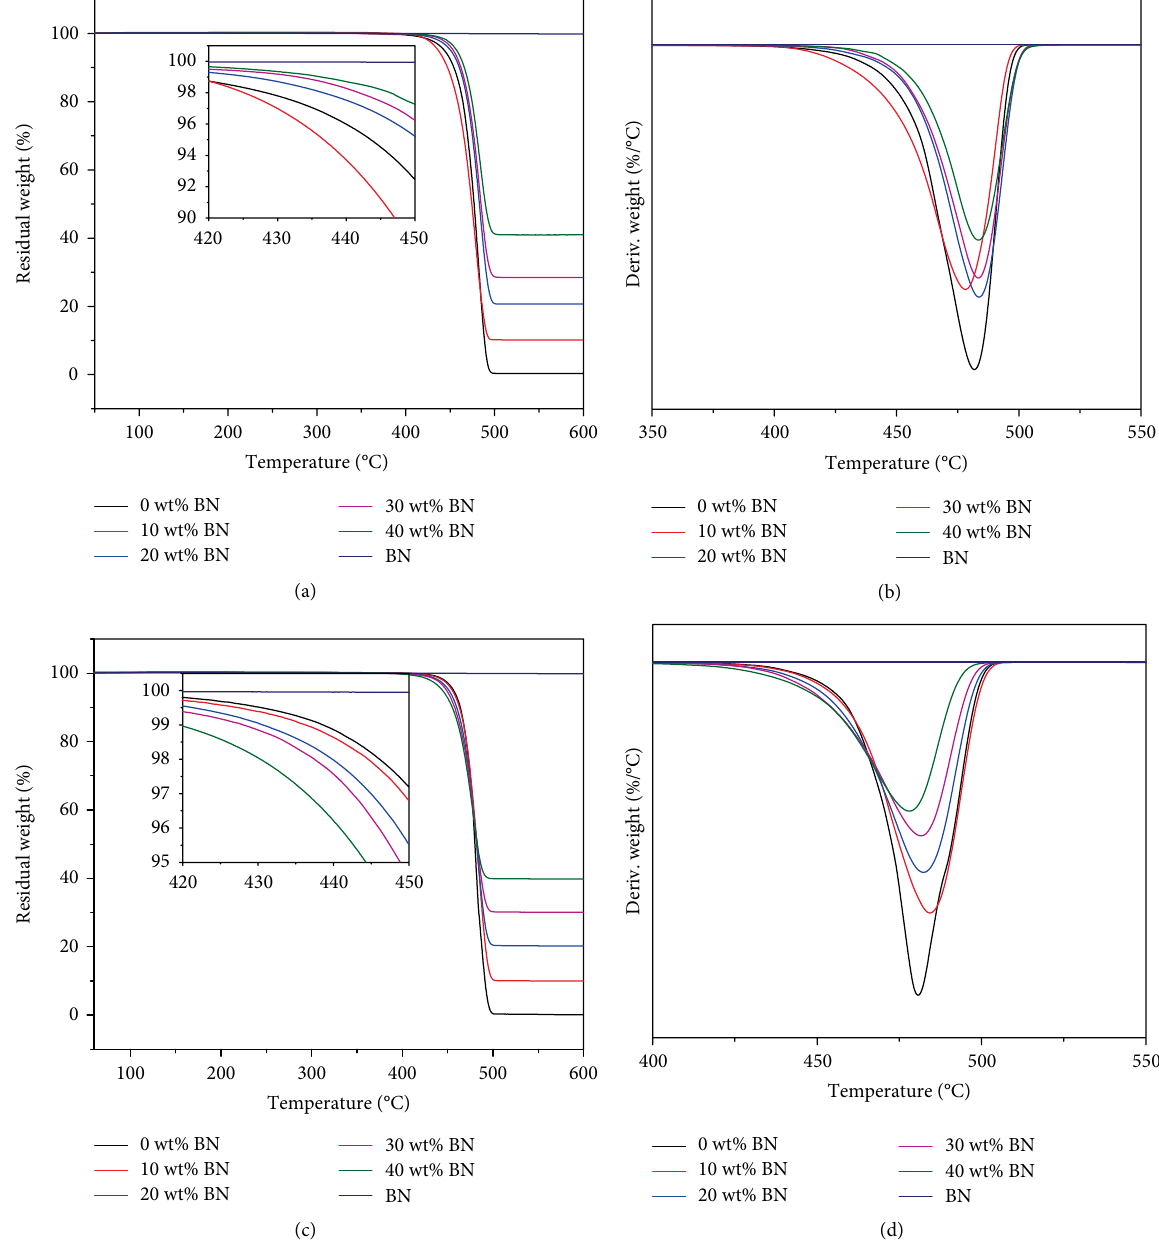
Figure 5: TGA and DTA curves of UHMWPE/BN composites by solvent mixing (a) (b) and melt mixing (c) (d). Table 3: Thermal stabilities of the composites by different mixing obtained from TGA